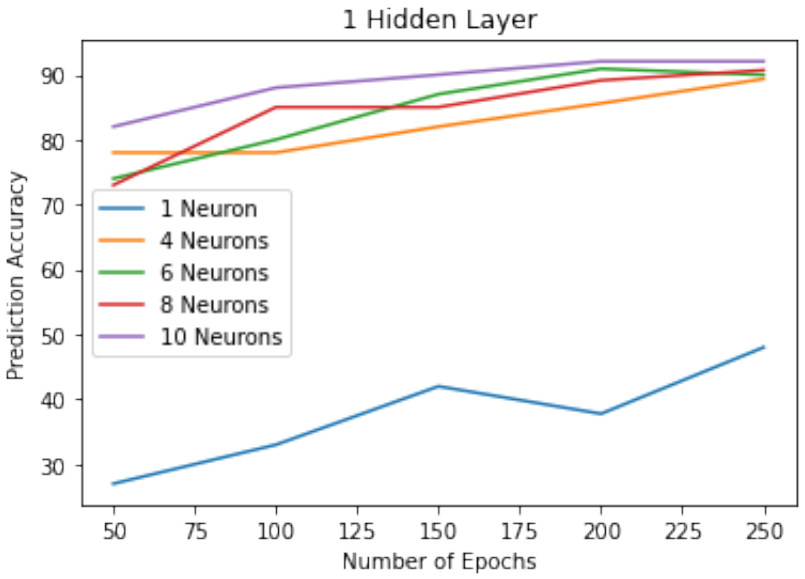
Figure 7. The effect of increasing Neurons/Epochs on the ANN prediction accuracy (%). To check if increasing the number of hidden layers of the ANN model would increase the prediction accuracy, further layers were tested with the same number of neurons each time as the previous layer (e.g., if the first hidden layer has four neurons, then the second was tested with four neurons and the third with four neurons as well). The epochs number remained the same at 200 epochs. The results showed that adding a second hidden layer, with one neuron, to the model decreased the prediction accuracy from 37.77% to 16.03%. Adding a third layer with one neuron did not improve the results. However, adding further layers to the models with neurons 6, 8, and 10 slightly improved the results, as shown in Figure 8. Adding a second hidden layer with 10 neurons improved the results of the model from 92.06% to 93.2%. A third layer further improved the results to 93.75%, which was the best result achieved compared to other models tested. Adding more layers after the third layer did not improve the results in any of the